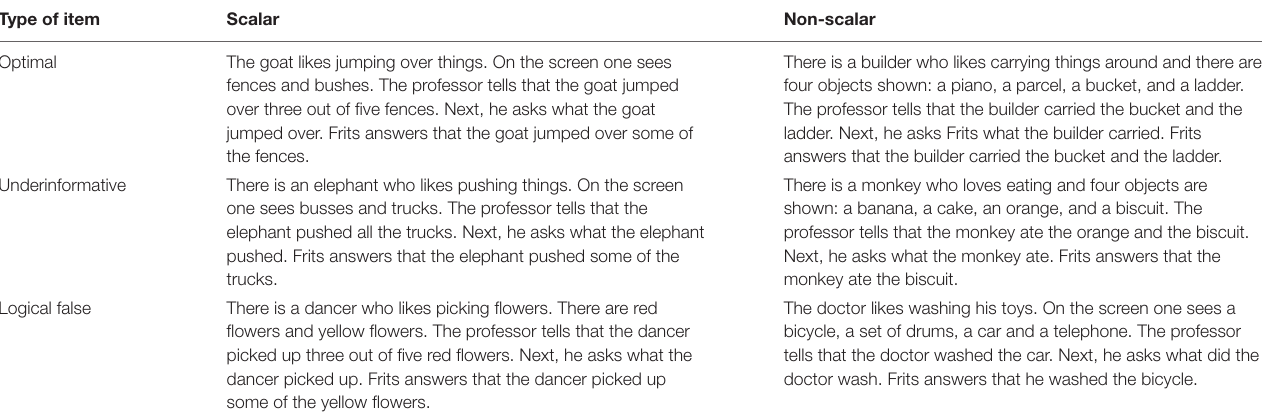
TABLE 1 | Examples of stories. Type of item Scalar Non-scalar